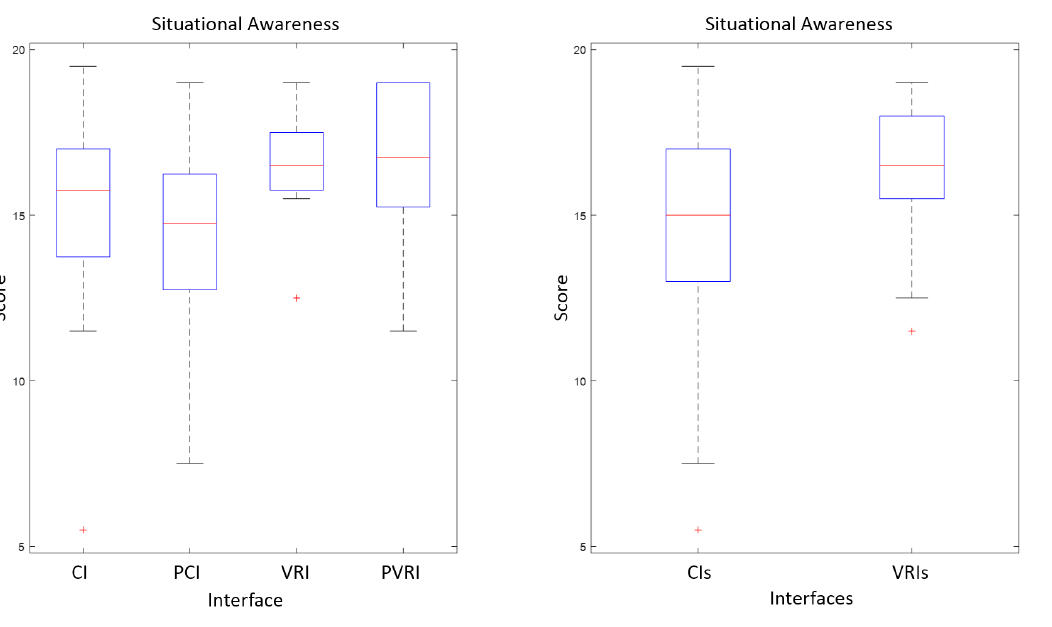
Figure 16. Box and whisker diagrams for the situational awareness with four interfaces ( left ) and two groups of interfaces ( right